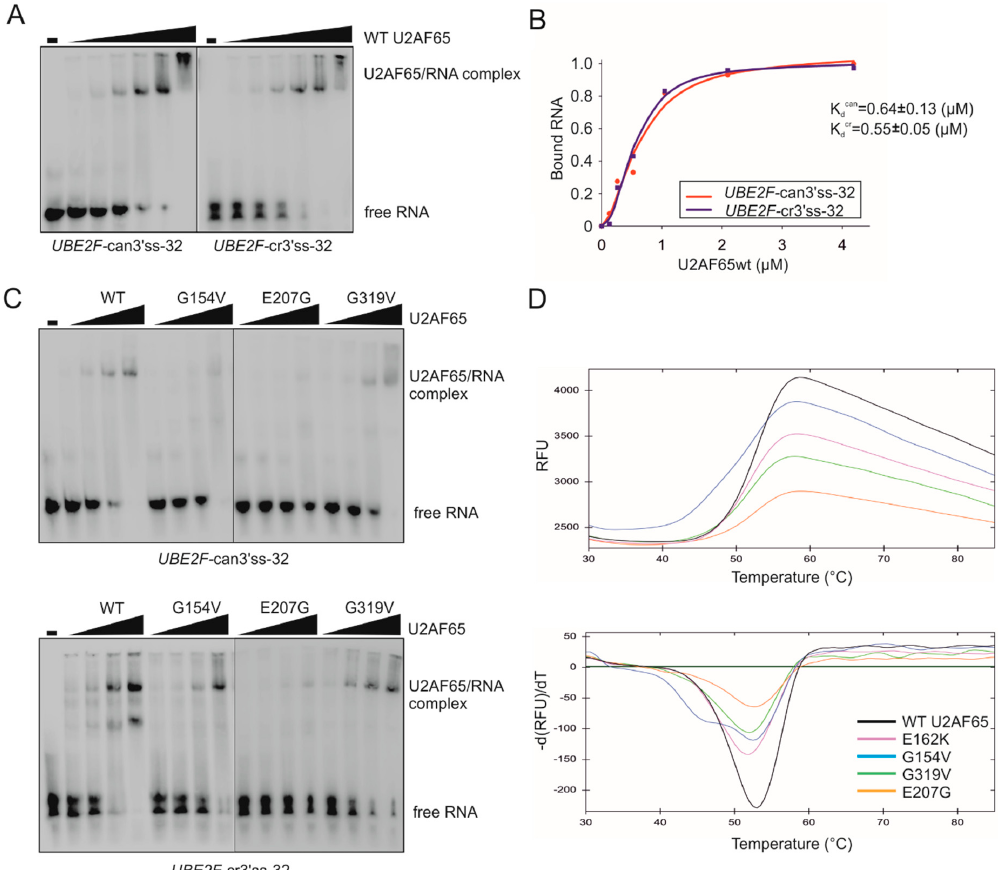
Figure 6. Cancer-associated U2AF65 RRM substitutions impair RNA binding and denaturation profiles. ( A ) In vitro binding of WT U2AF65 to PPTs of canonical and cryptic 3 ′ ss of UBE2F exon 5, Concentrations of recombinant U2AF65 proteins were 0.13, 0.26, 0.52, 1.05, 2.1 and 4.2 μ M. Sequences of RNA probes are in Table 1. ( B ) Fractions of bound RNA probes and K d estimates. ( C ) Impaired binding of representative mutated U2AF65 to each PPT. Concentrations of recombinant U2AF65 were 0.26, 0.52, 1.05 and 2.1 μ M. Concentration of biotin-labeled RNAs (bottom) was 17 nM. ( D ) Thermal denaturation profiles of U2AF65 RRM mutants determined by DSF with SYPRO Orange as a thermofluor. Melting curves are in the upper panel and melting peaks are in the lower panel.